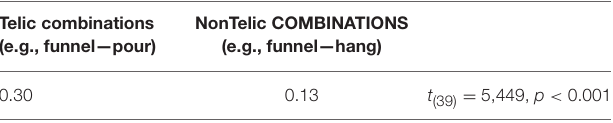
TABLE 3 | Semantic Similarity Values (SSVs) between the noun and the verb in Telic and NonTelic combinations. Telic combinations (e.g.,